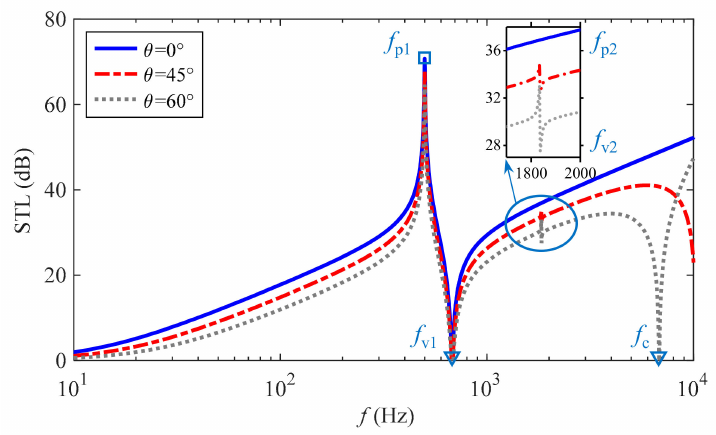
Figure 4. Sound insulation properties of the metamaterial with single-modal resonant frequency vary with elevation